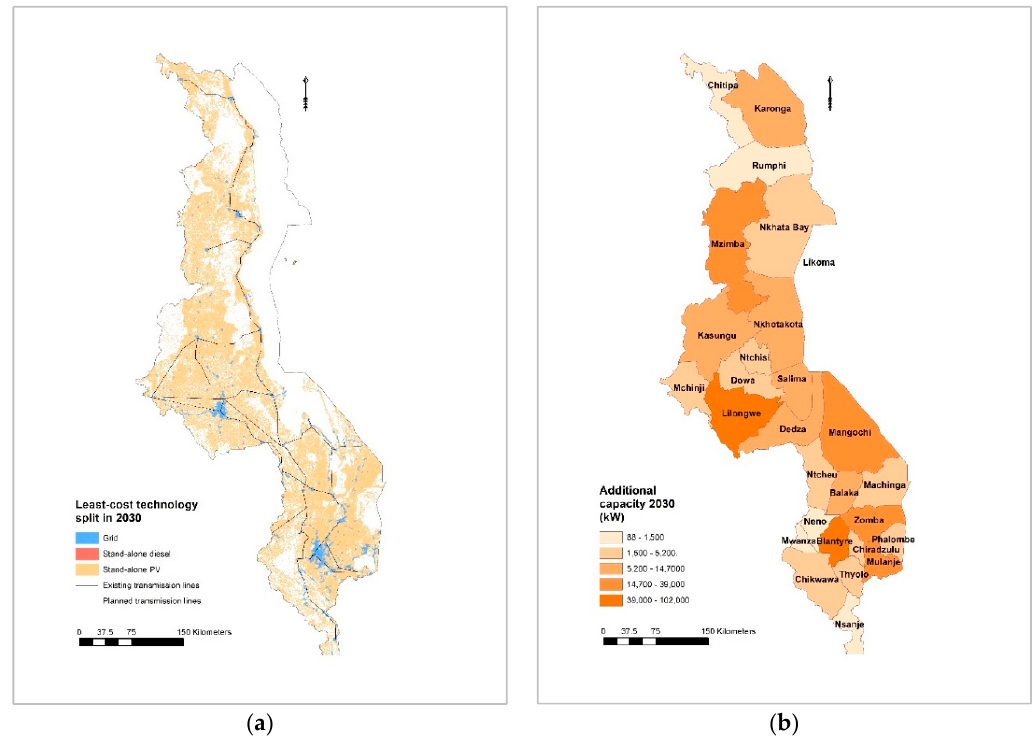
Figure 6. Least cost technology split ( a ) and additional capacity ( b ) required per province to reach universal access to electricity in Malawi by 2030.